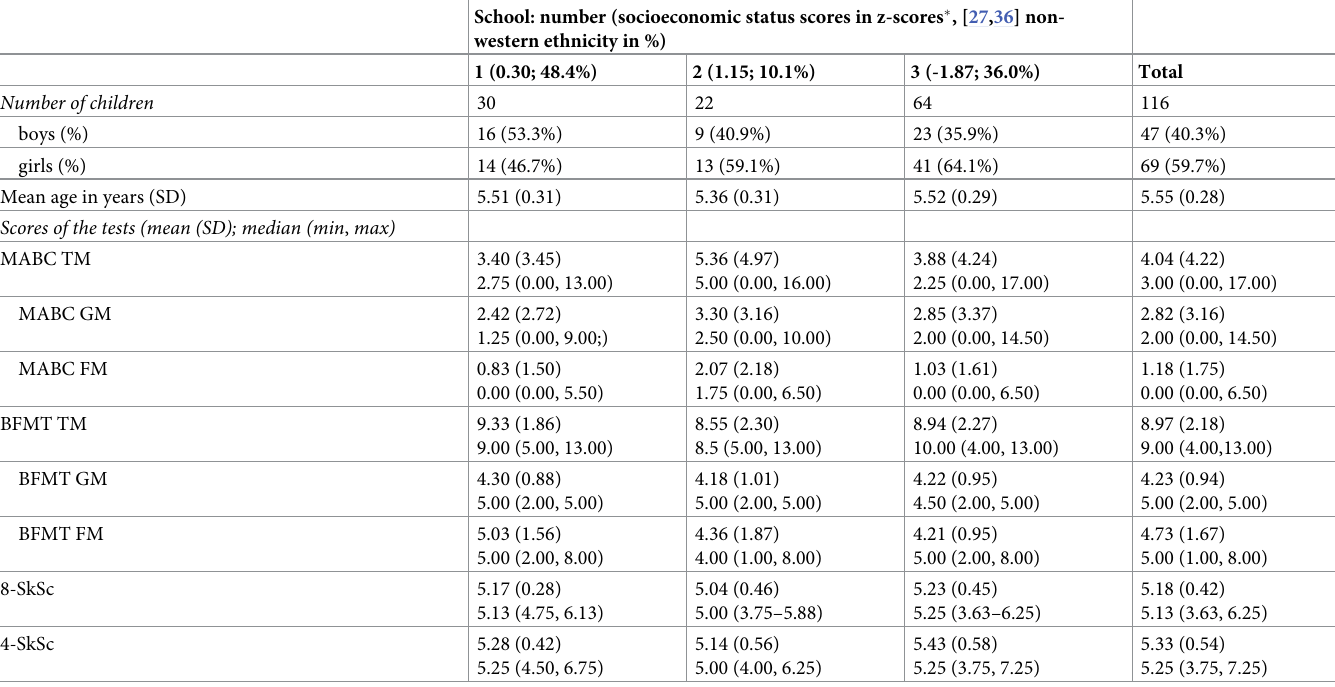
Table 2. Background characteristics and scores of the motor tests of the children (N = 116) in relationship to the characteristics of the schools. School: number (socioeconomic status scores in z-scores � , [27,36] non- western ethnicity in %) 1 (0.30; 48.4%) 2 (1.15; 10.1%) 3 (-1.87;